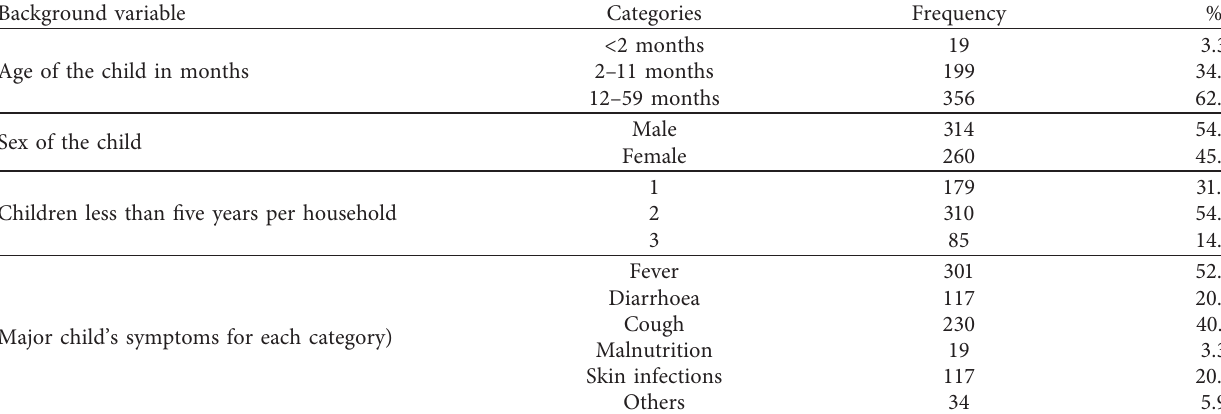
Table 2: Sociodemographic variables and major disease symptoms among under-five children who participated in the study of Hadiya zone, Ethiopia, June 2018 ( n �